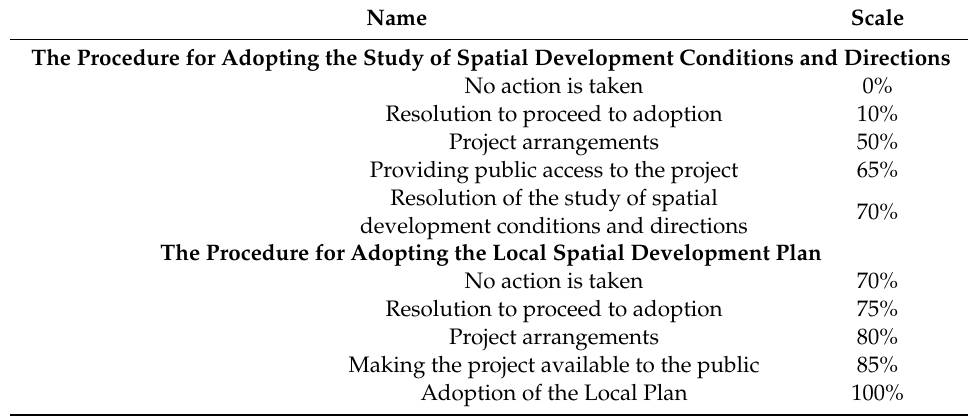
Table 5. Percentage scale of the advancement of the process of including the power plant and the power line in the local spatial development plan.